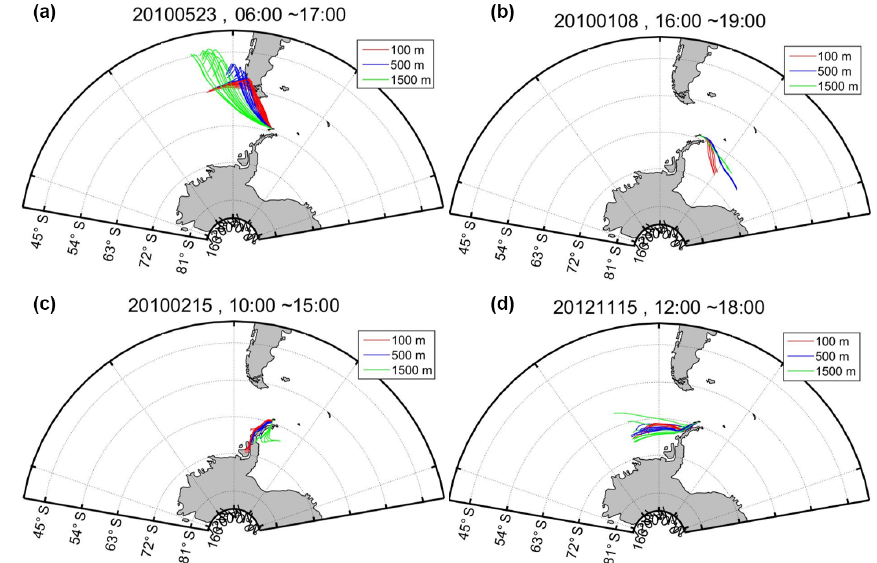
Figure 2. Example of the four cases considering the air mass origin and pathway: (a) South America, (b) Weddell Sea, (c) Antarctic Peninsula and (d) Bellingshausen Sea. Typical 48h air mass backward trajectories were analyzed, ending at heights of 100m (red line), 500m (blue line) and 1500m (green line) above the ground level of the sampling site.